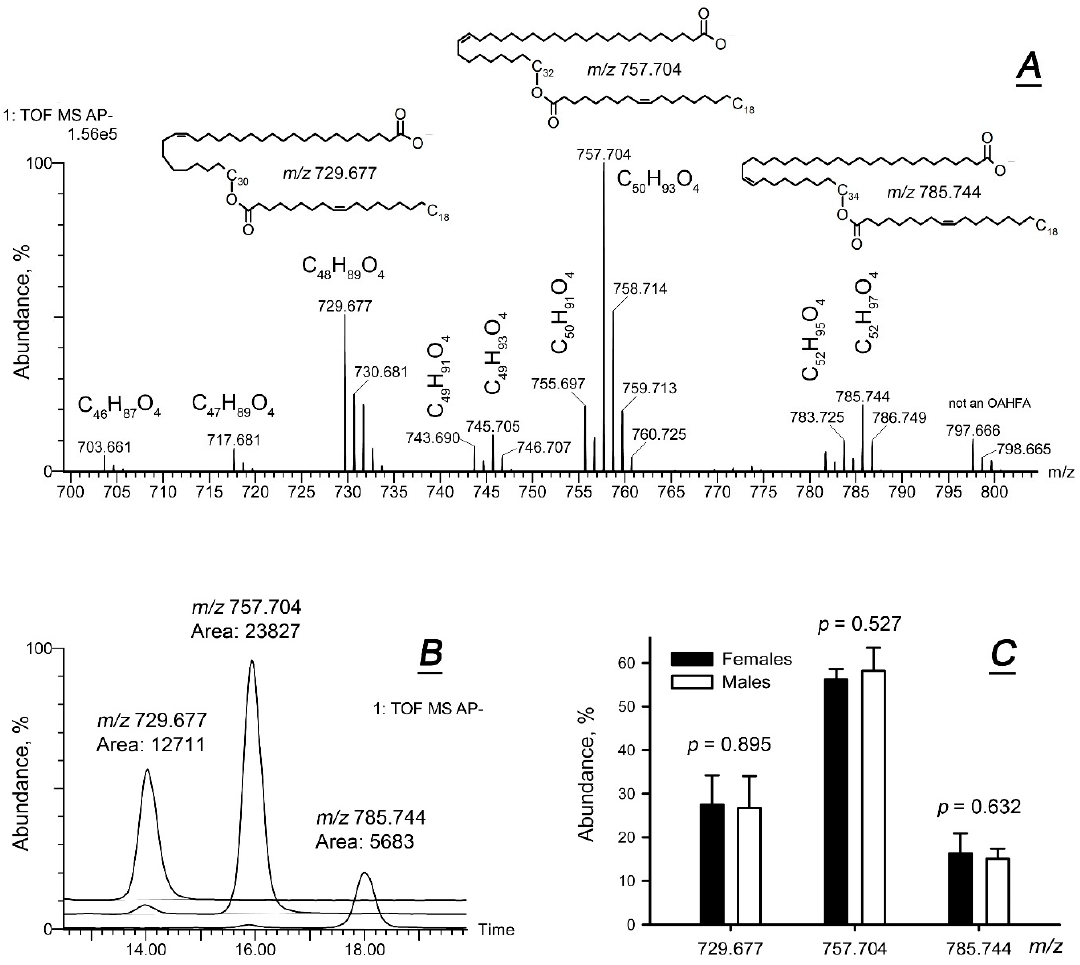
Figure 4. Targeted lipidomic analysis of amphiphilic lipids in female and male meibum. The makeup of ( O )-acylated omega-hydroxy fatty acids (OAHFAs) showed no di ff erences between the sexes. ( A ) An observation spectrum of a representative human meibum sample obtained in negative ion mode and structures of three prominent OAHFA species. ( B ) Extracted ion chromatograms of three major OAHFAs of human meibum, overlaid and integrated. ( C ) Relative abundances of three representative OAHFA species in female and male meibum ( n = 9 for each gender group). No di ff erences were observed for other OAHFA species, either.